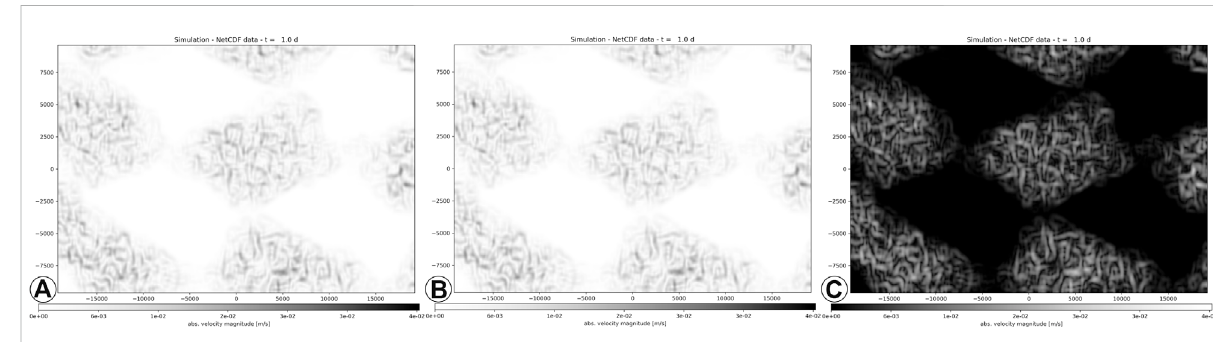
FIGURE 8 Illustration of lacking correspondence in inversion transformation on intensity-mapped images of | v| Ł compared to the original ( D → R ( α ) → D ◦ α ′ ◦ r ◦ ω ; (B) differs from inverting the visual transformation ( V V ( ω ); (A) , inverting the data ( V 2 =